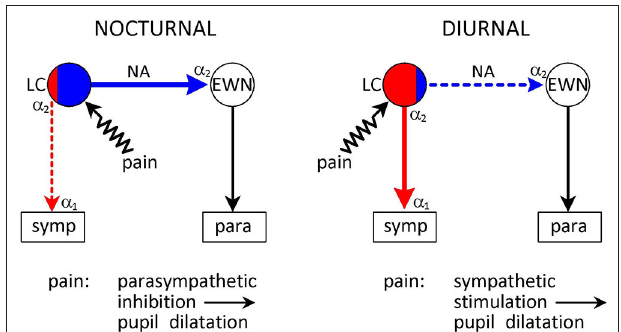
FIGURE 5 | Species-specific effects of noxious stimulation on the pupil. Conventions are as in Figure 3 . Pain signals arising from noxious (painful) stimulation are conveyed to the LC via collaterals from the spinothalamic tract. Pain signals evoke pupil dilation (“reflex dilation”) in both nocturnal and diurnal animals. However, the mechanisms are different. In nocturnal animals pain signals stimulate parasympathetic premotor neurones in the LC that project to the EWN to stimulate inhibitory α 2 -adrenoceptors, mediating a parasympatholytic effect. On the other hand, in diurnal animals pain signals stimulate sympathetic premotor neurones in the LC, leading to a sympatho-excitatory effect. See text (Collaterals From Spinothalamic Tract) for